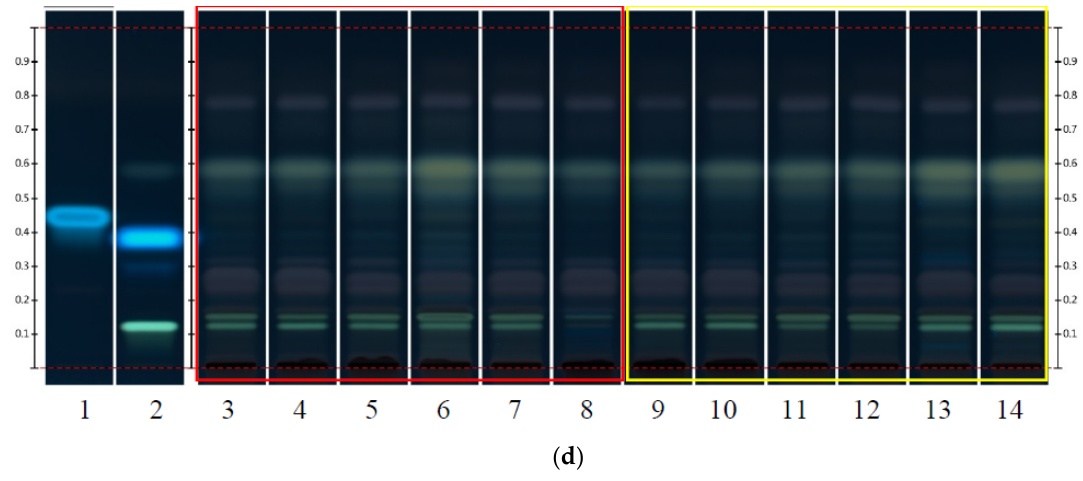
Figure 2. HPTLC fingerprints of Angelica sinensis cultivated in Gansu (tracks 3–8) and Yunnan (tracks 9–14). Isoimperatorin (R f = 0.46), Imperatorin (R f = 0.38), ferulic acid (R f = 0.12), osthole (R f = 0.33) and Z ‐ ligustilide (R f = 0.59) were used as reference substances. ( a ) Image of the plate prior to derivatization under UV 254 nm; ( b ) Image of the plate prior derivatization under UV 366 nm; ( c ) Image of the plate after derivatization under WRT; ( d ) Image of the plate after derivatization under UV 366 nm.